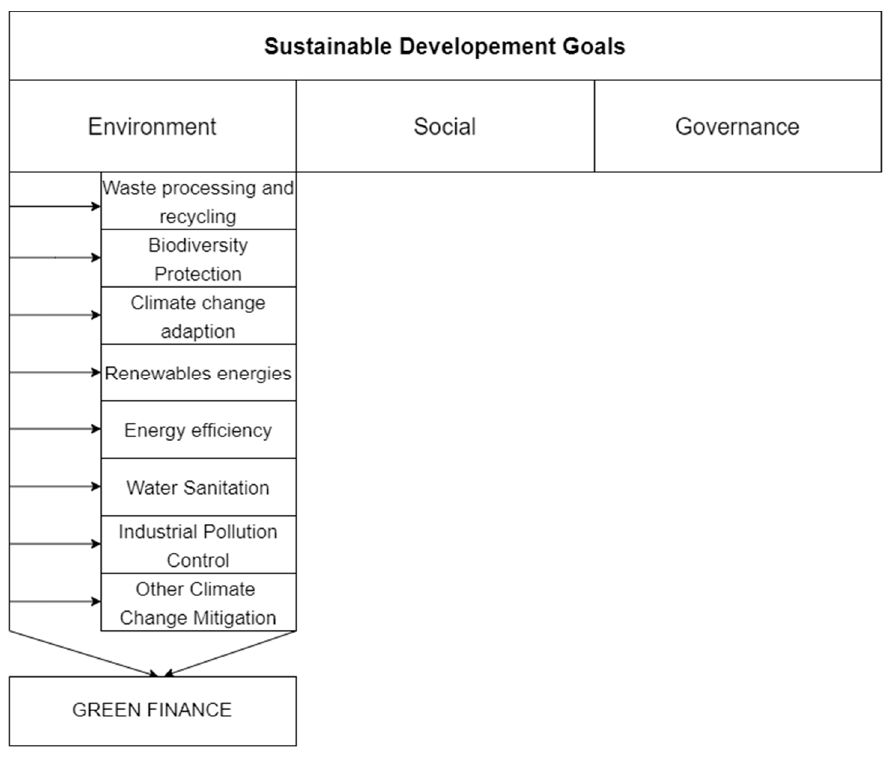
Figure 1. Green finance with regard to sustainable development goals. Source: based on Saleem and Khan (2021).